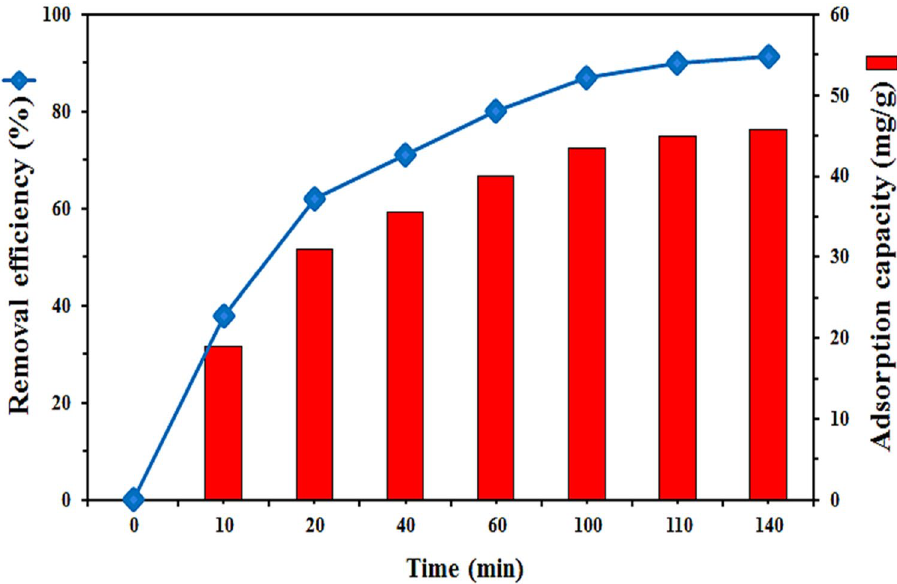
Figure 7. The effect of contact time on the removal efficiency of RO16 onto lignocellulosic sawdust-Fe/Zn bio- nanocomposite, and the adsorption capacity at different times (initial pH 4, 20 mg lignocellulosic sawdust-Fe/